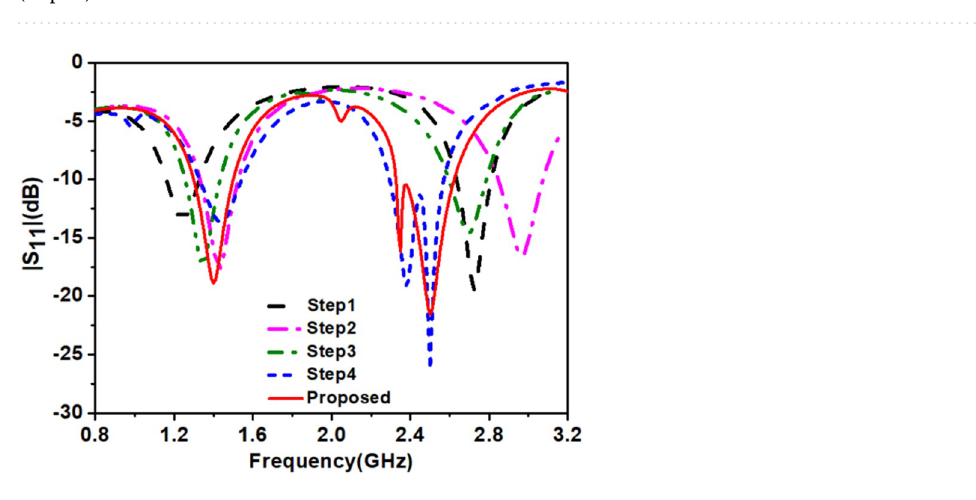
Figure 5. |S 11 | of optimization